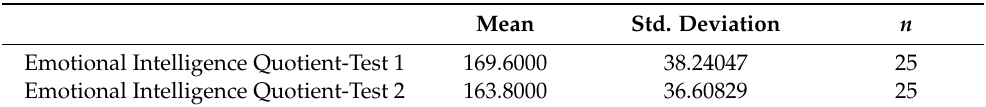
Table 10. Mean results for emotional intelligence quotient for the ANCOVA model for Group II pre-test and post-test measurements.